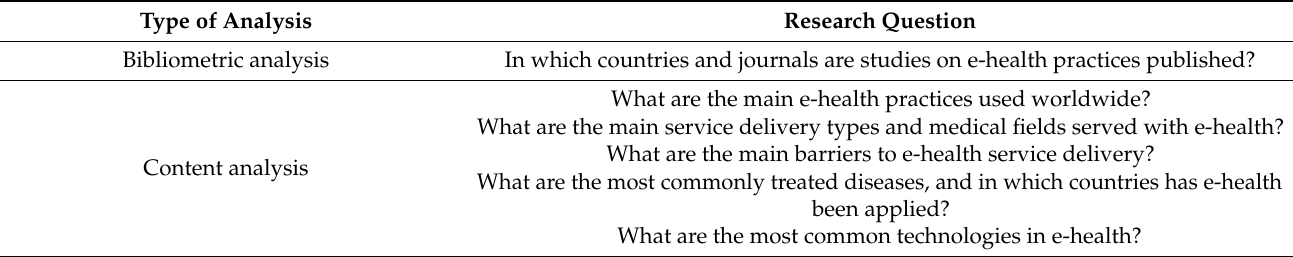
Table 1. Type of analysis used to address the research